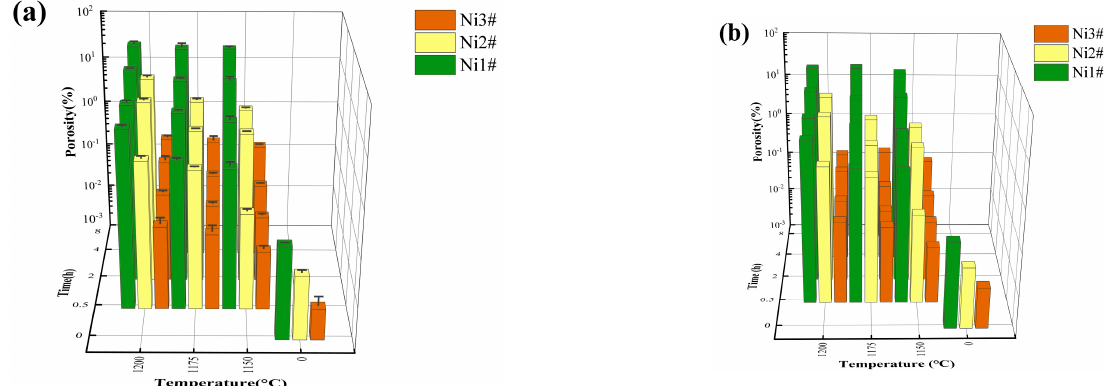
Figure 10. Evolution of the TIP as a function of holding temperature and holding time; ( a ) the average value of the TIP and ( b ) the worst value of the TIP.